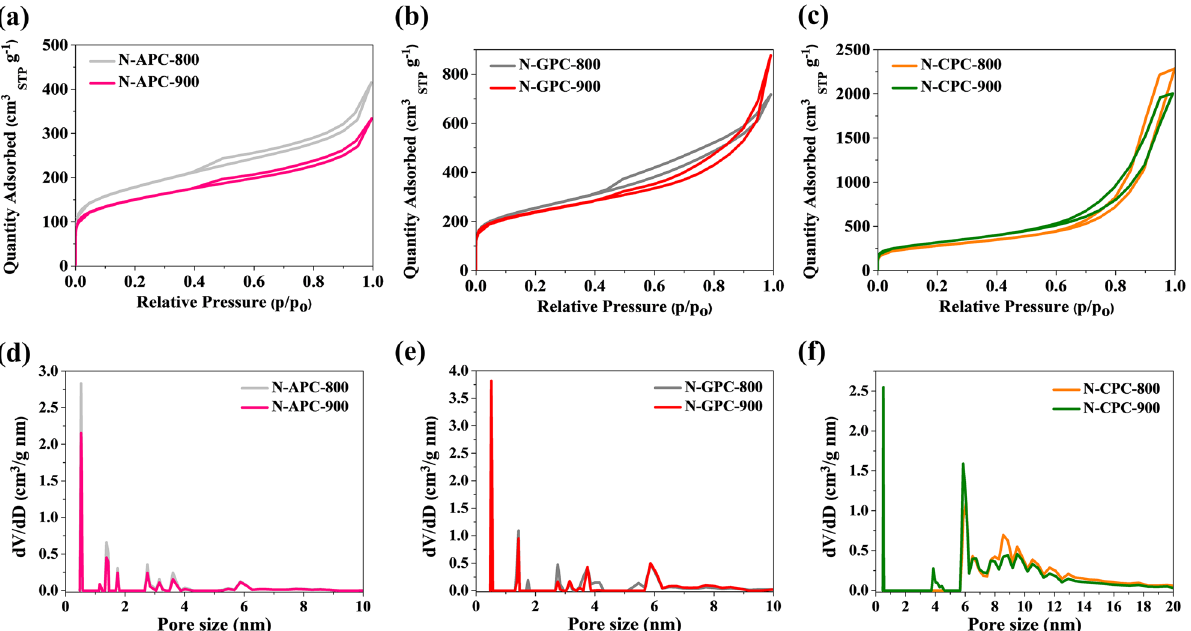
Figure 2. ( a – c ) Nitrogen adsorption–desorption isotherms, ( d – f ) pore size distribution calculated from N 2 sorption isotherms using the DFT method.